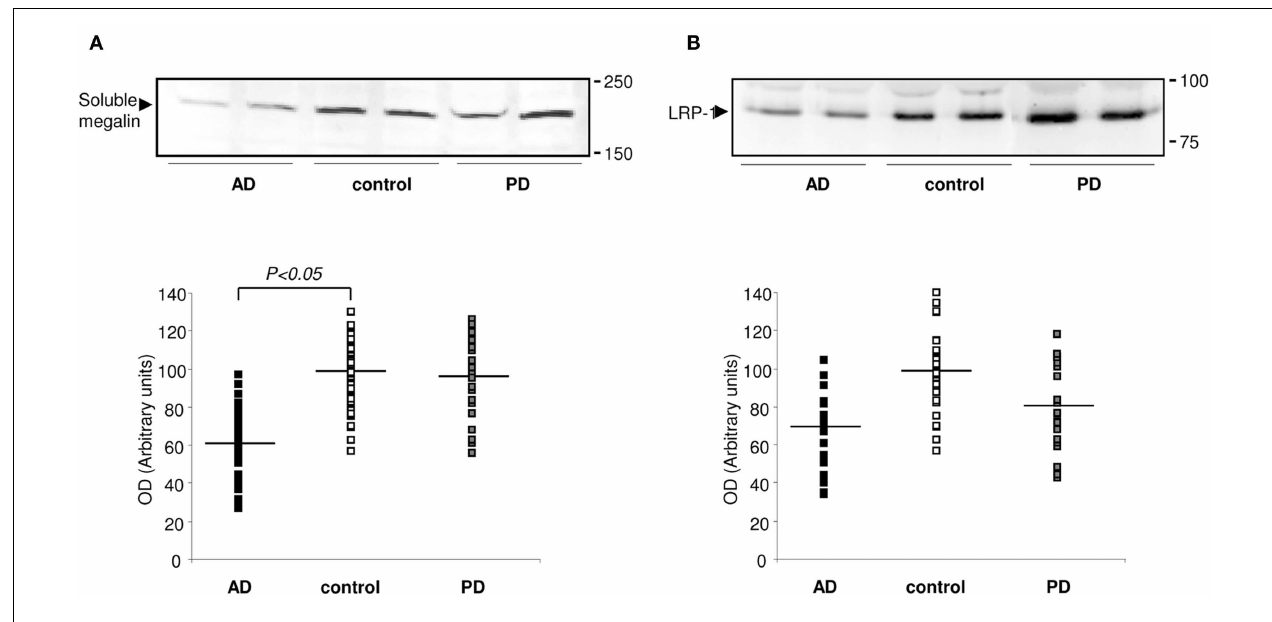
disease (AD; black), and Parkinson’s disease (PD; gray). Scatter plots represent results from three replicates. Results are expressed as mean ± SEM. * p <